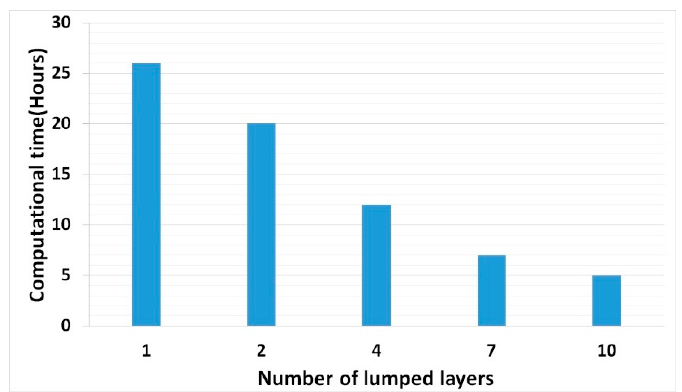
ff erent lumped layers for the cubic